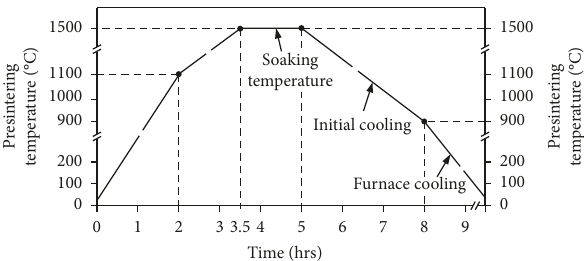
Figure 6: Temperature schedule for presintering